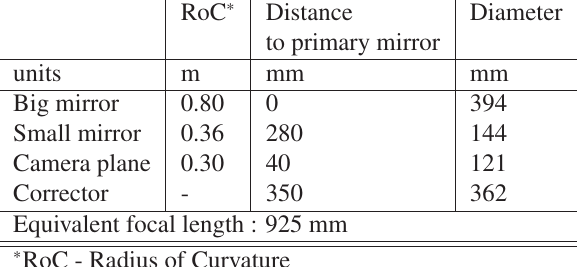
Figure 3: Left : View from the top of the payload of Terzina. Right : Side view and SiPM camera. Table 1: Parameters of the optical system